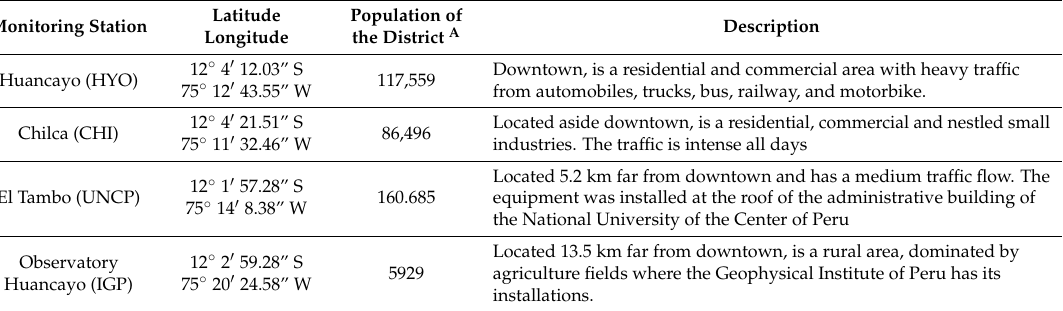
Table 1. Short description of the monitoring